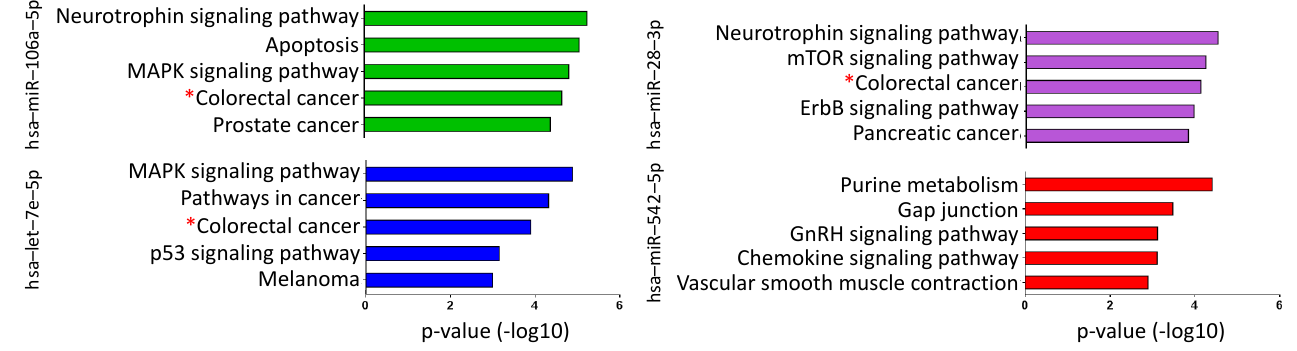
Figure 6. Biological pathways enriched with the mRNAs predicted to be targets of miR-106a-5p, let-7e-5p, miR-28-3p, and miR-542-5p. The colorectal cancer pathway (red star) is among the most significant pathways for three out of four tested miRNAs (miR-106a-5p, let-7e-5p, and miR-28-3p). p -Value expressed as − log 10